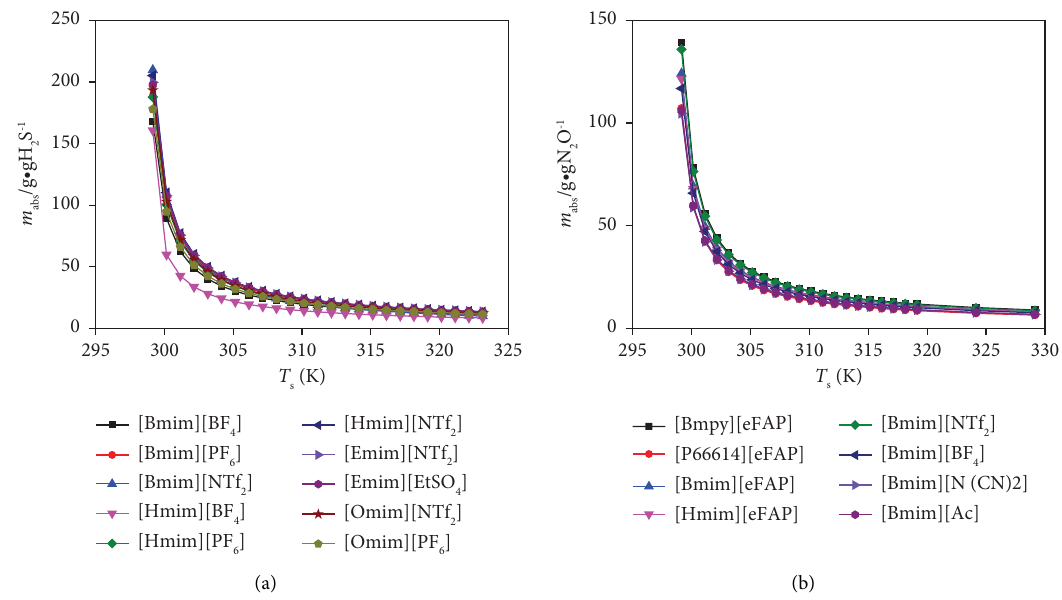
Figure 6: Te absorbent amount of (a) 10 physical absorbents for high-sulfur natural gas and (b) 8 physical absorbents for adipic acid